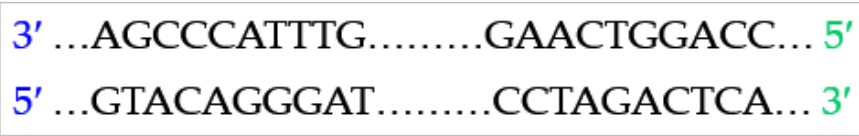
Figure 2. A sample of received primers for the optimal DNA codes.